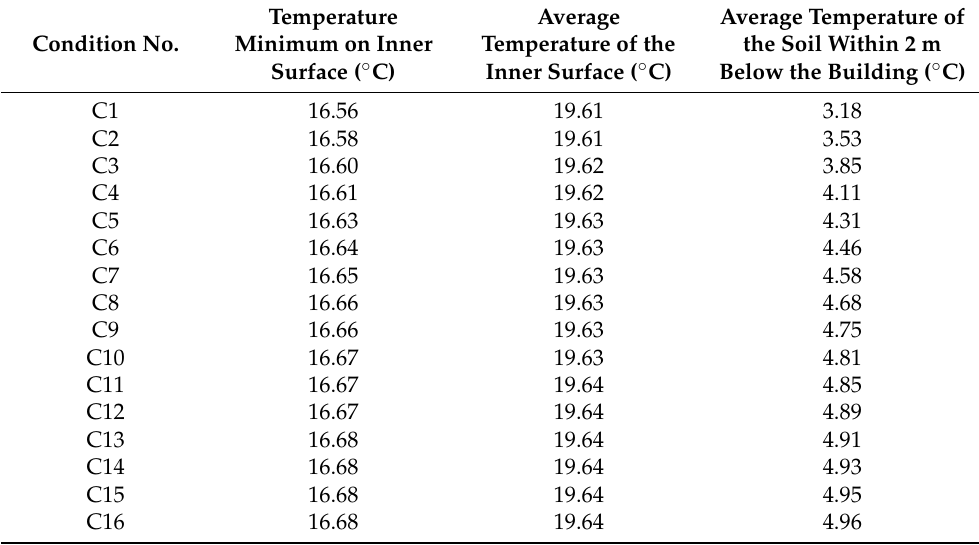
Table 6. Simulation results for Group C working